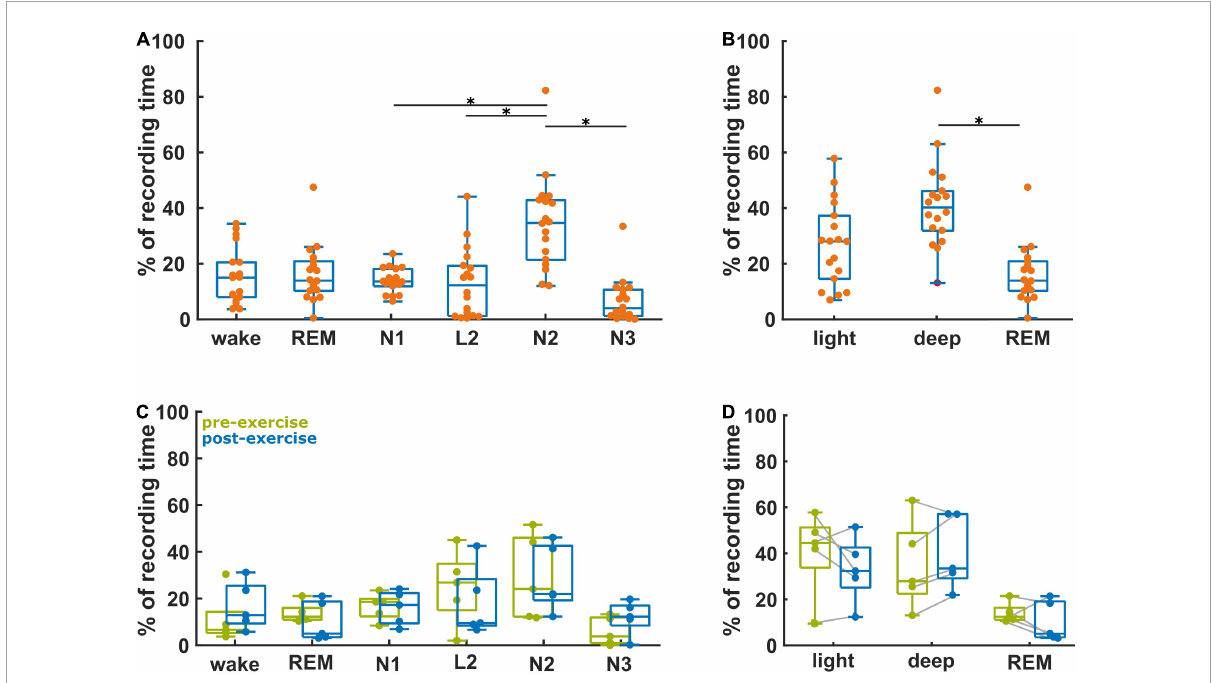
FIGURE2 Proportion of the vigilance states derived from the baseline recordings ( n = 18) and the ratio of the vigilance states between the baseline and post-aerobic exercise recordings from five participants. (A) Distribution of vigilance states for all 18 baseline recordings. (B) Distribution of light sleep (N1 + L2), deep sleep (N2 + N3) and REM sleep at baseline ( n = 18). (C) Relative change of the vigilance states from baseline to post-aerobic exercise recordings ( n = 5). (D) Relative change of light sleep, deep sleep and REM sleep from baseline to post-aerobic exercise recordings ( n = 5). *Represent the TCassim.